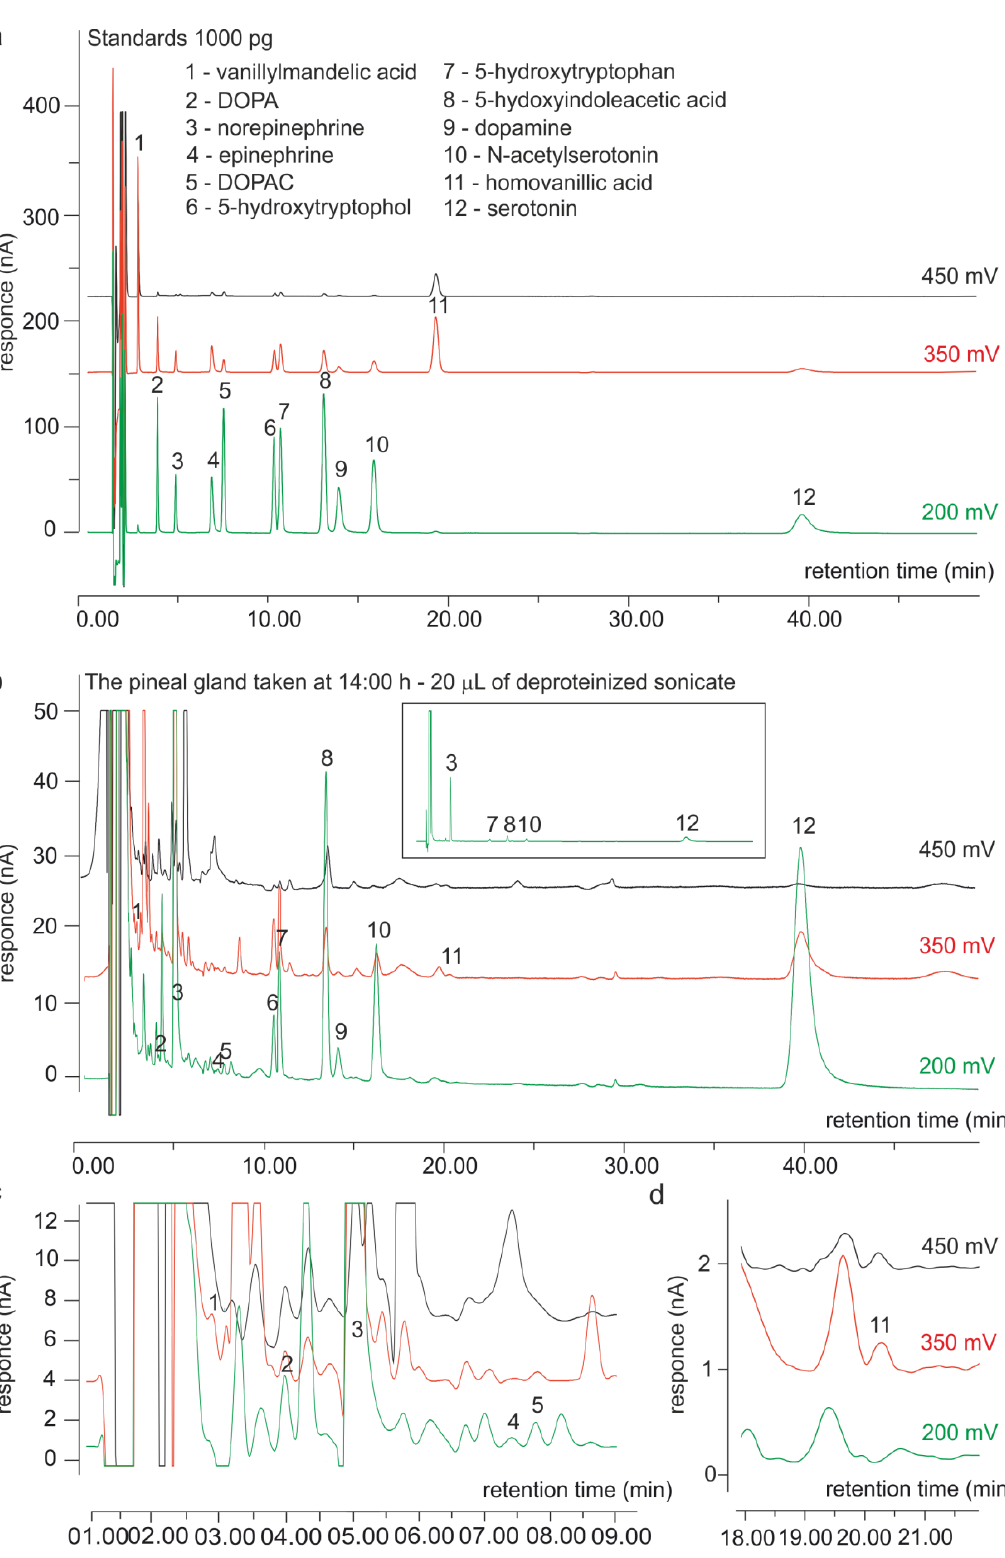
Figure 3. Chromatograms obtained using HPLC with electrochemical detection. ( a ) Separation of synthetic compounds applied as standards (1000 pg per injection); ( b – d ) Analysis of the duck pineal homogenate prepared from the organ taken at 14:00 h (20 µL per injection). For visualizing all peaks, different time and response scales were used in panels b , c , and d